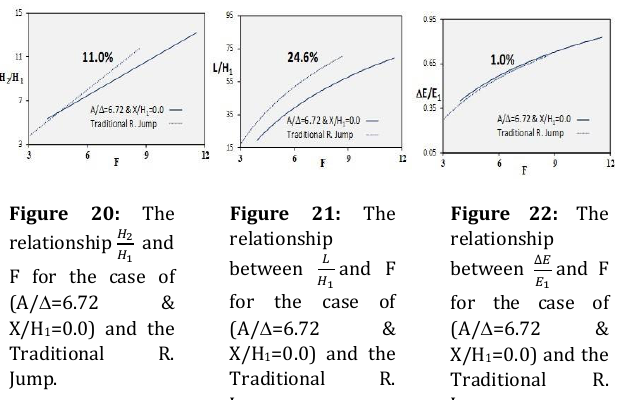
Figure 26: The relationship between the residuals’ values versus the statistical training comparative height of the free H. jump Eq. (2).